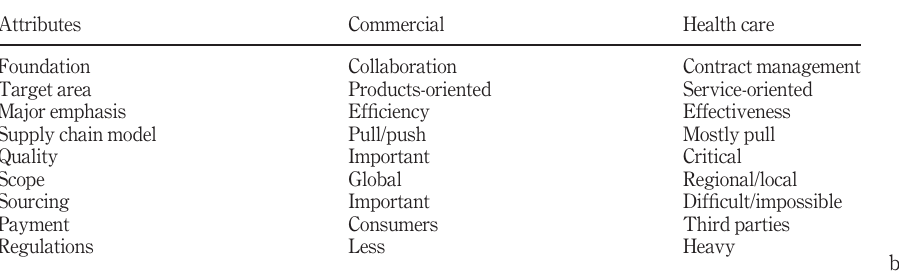
Table I. Areas of emphasis